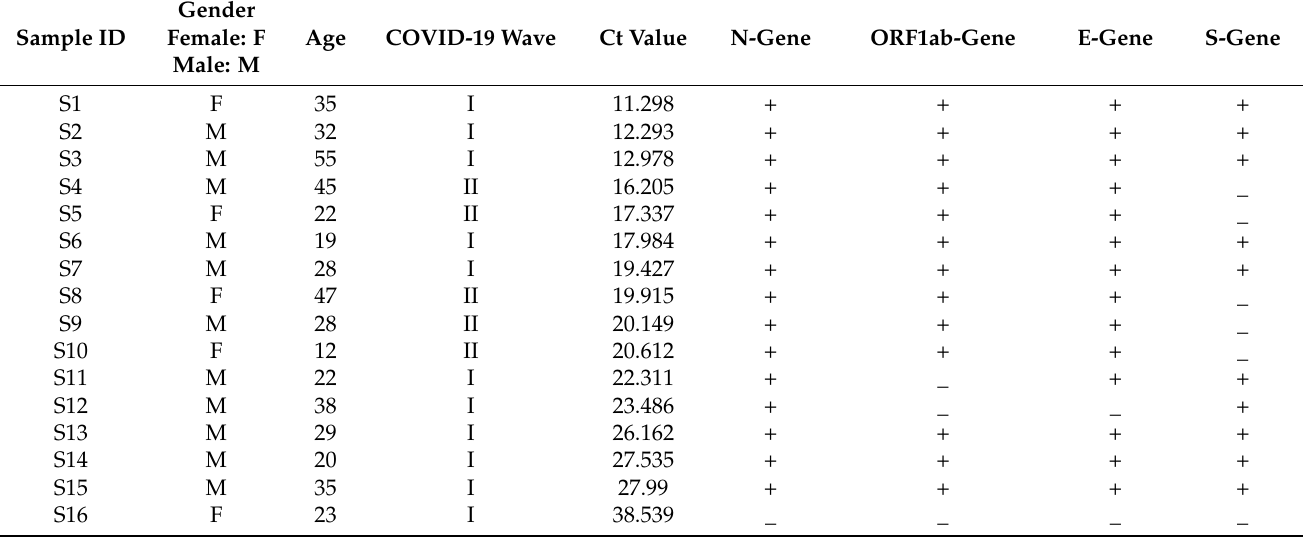
Table 1. Validation of LFD for clinical samples of SARS-CoV-2 viral